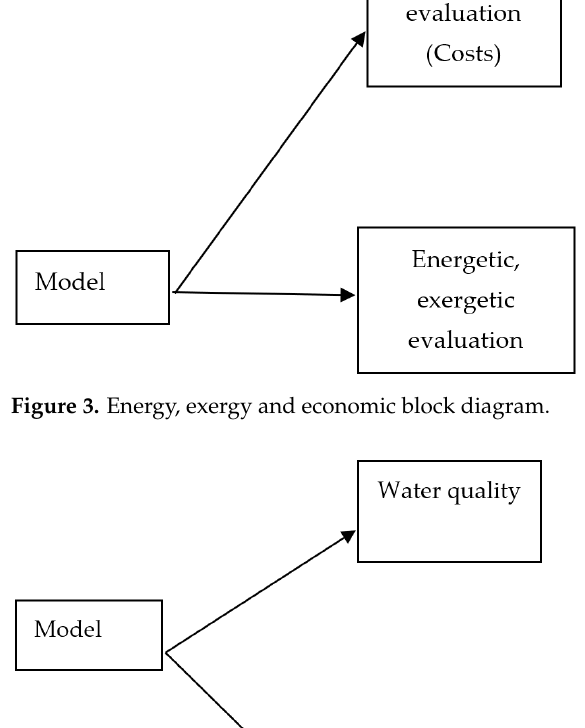
Figure 4. Environmental and water quality block diagram.